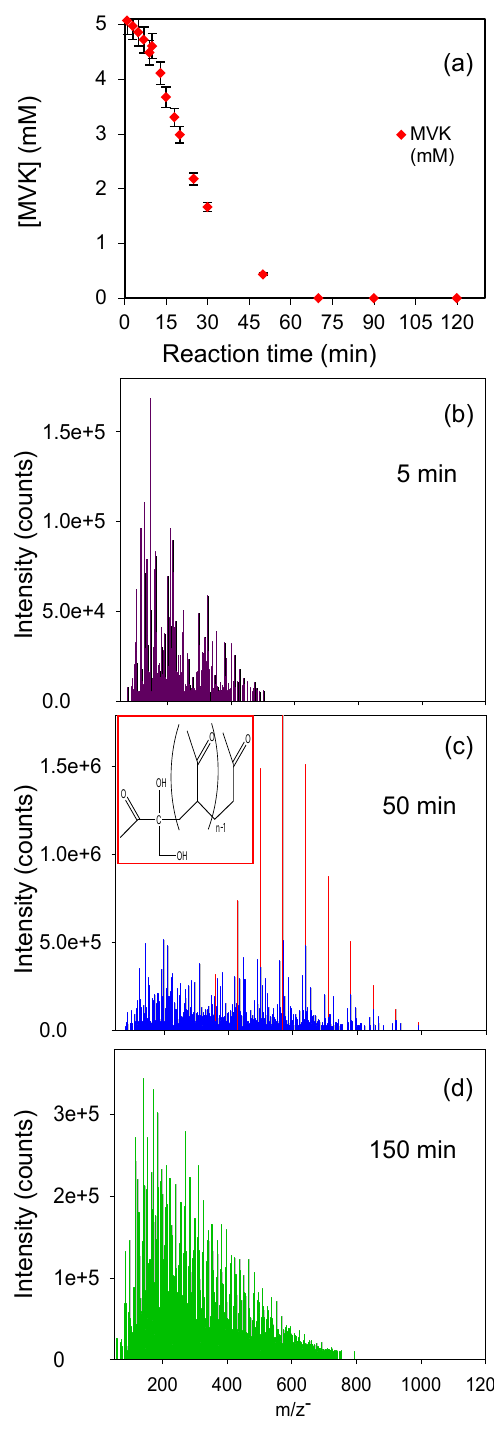
Figure 2. (a) Time profiles of MVK concentrations during the re- action (experiment B); and the corresponding evolution of ESI-MS spectra for m/z 50–1200 at (d) 5min, (c) 50min and (d) 150min. Highlighted in red in (c) , the most intense peaks of the main series of oligomers together with their related molecular